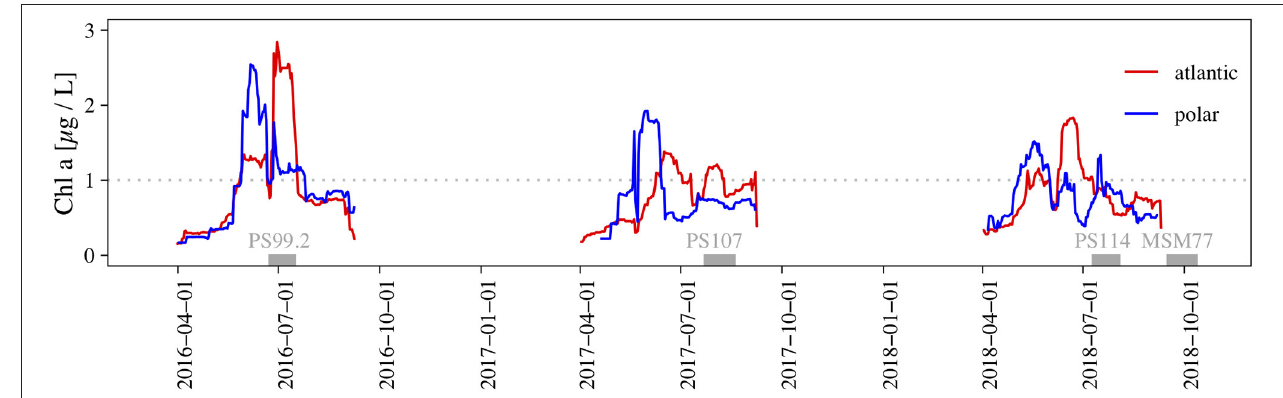
FIGURE 5 | Time series of satellite derived chlorophyll- a concentration estimates. The distinction of Polar and Atlantic areas is described in the materials and methods section. We used daily chlorophyll- a estimates and applied a 15 d moving average, weighed by the number of available data points. Gray bars indicate the duration of sampling campaigns and the dotted gray line indicates the threshold chlorophyll concentration we imposed for classifying as a “bloom” (Wu et al., 2007; Nöthig et al.,